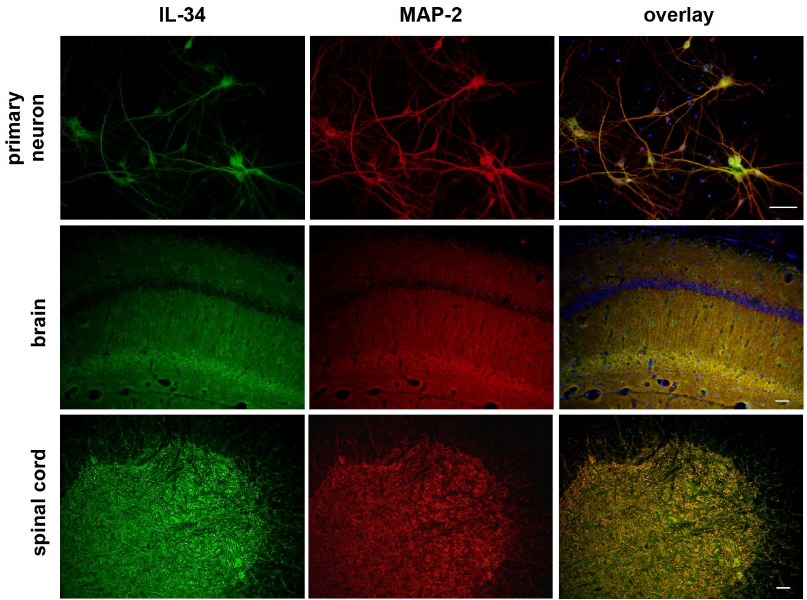
Fig. 1. IL-34 is produced by neurons in the CNS. Immunofluorescence images of primary cortical neurons, brain sections, and lumbar spinal cord sections. Green, IL-34; red, MAP-2; blue, Hoechst nuclear counterstain. Scale bar, 50 m